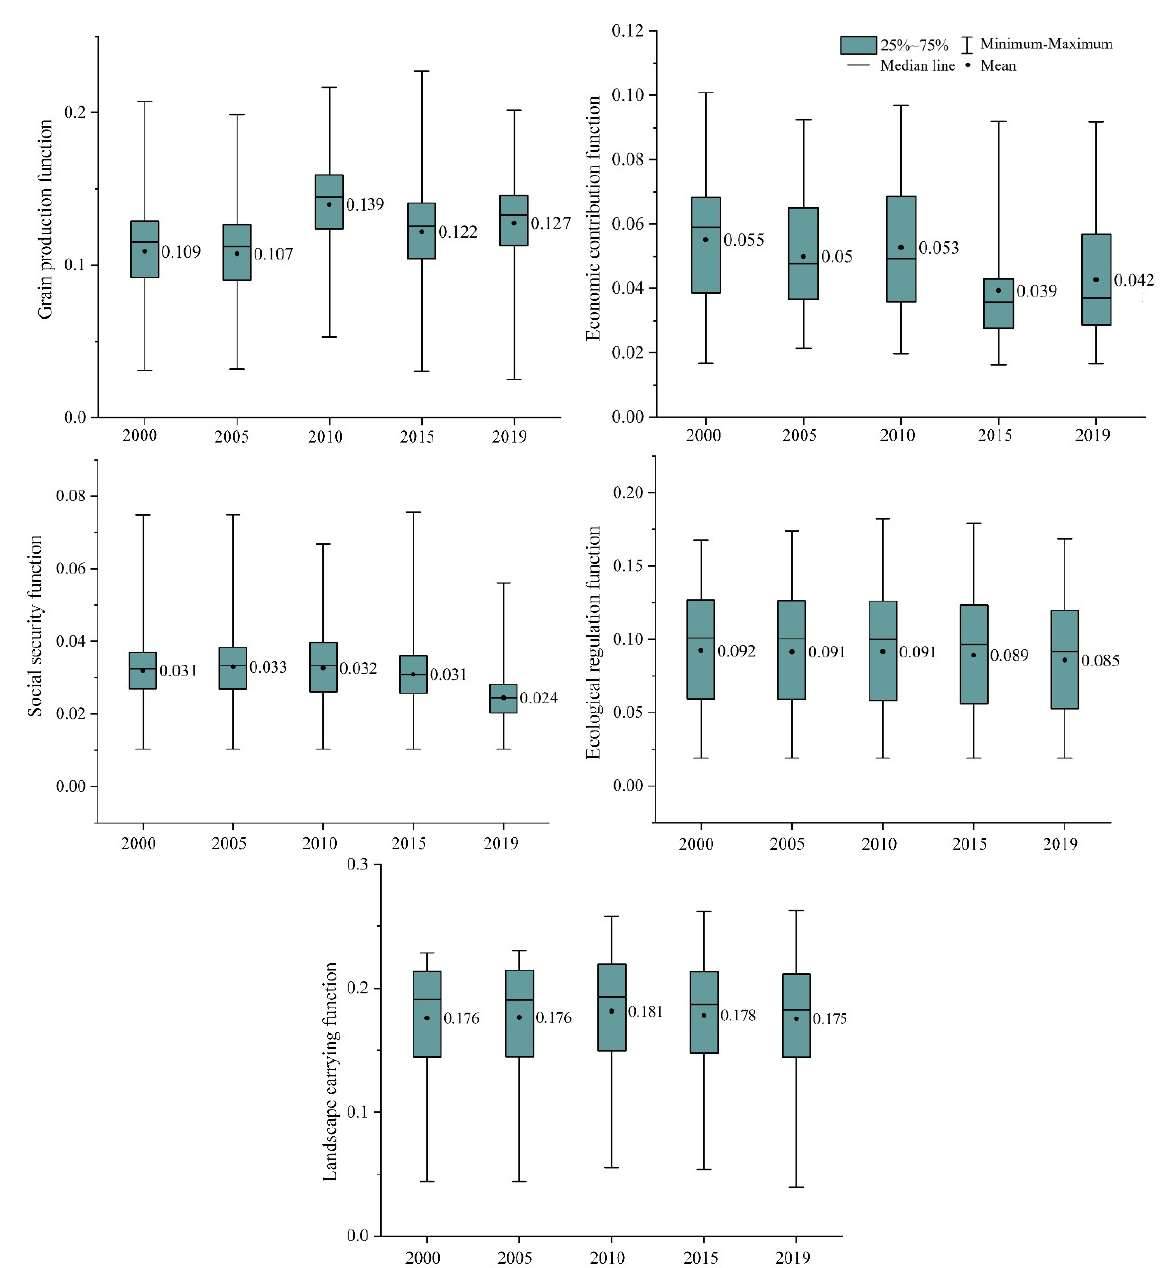
Figure 5. Kernel density curve of various functions of the cultivated land system. Figure 5. Box diagram of different functional indices of the cultivated land